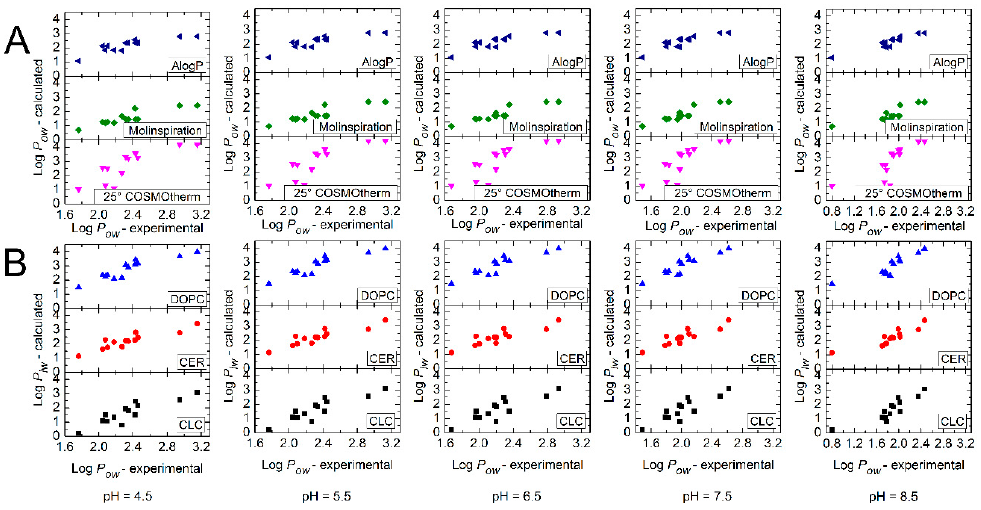
Figure A1. Relation between ( A ) calculated log P ow,calc and experimental log P ow,exp measured in phosphate buffer at pH 4.5–8.5; ( B ) calculated log P lw,calc values and experimental log P ow,exp measured in phosphate buffer at pH 4.5–8.5.